Question: Briefly state, in one sentence, what is plotted here.
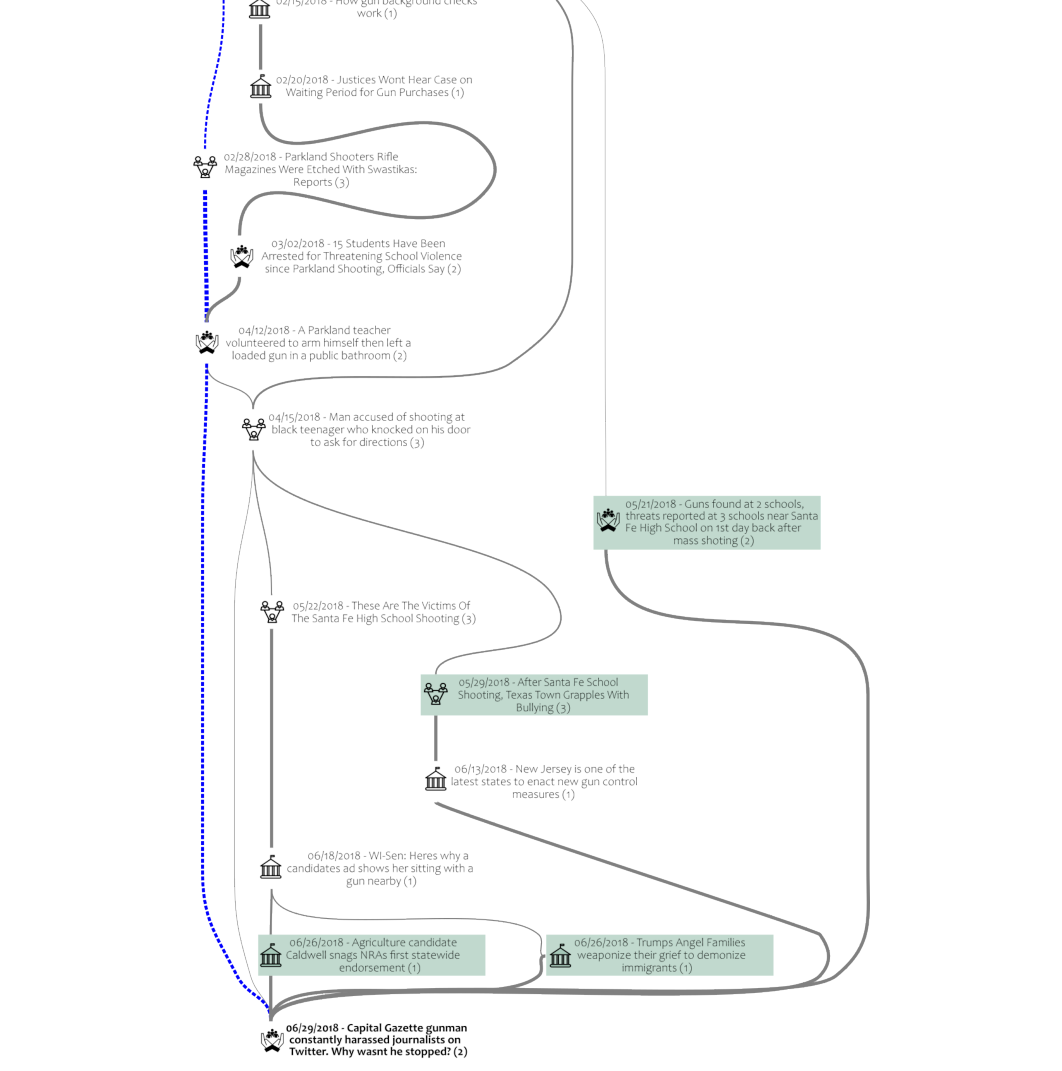
Answer: Sample narrative map extracted from news events spanning January to June 2018. Events are represented as nodes labeled with headlines and frames. Connections indicate narrative relationships between events. Inconsistencies in framing across the map highlight challenges in producing coherent framing narratives through the extraction process.